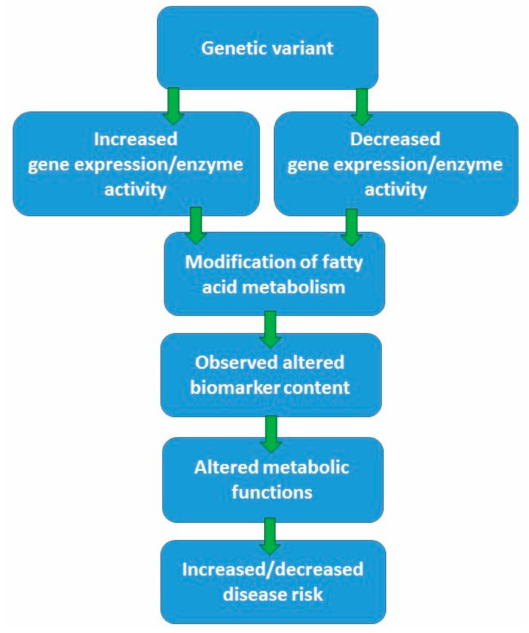
Figure 2. Impacts of genetic variants regulating fatty acid metabolism in the body. Table 1. Fatty acid ratios used for the estimation of desaturase and elongase